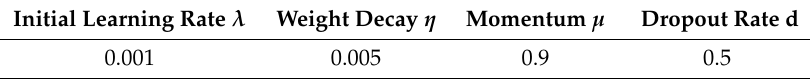
Table 1. The hyperparameters used for training. All parameters were obtained empirically during investigation of the training process on the validation